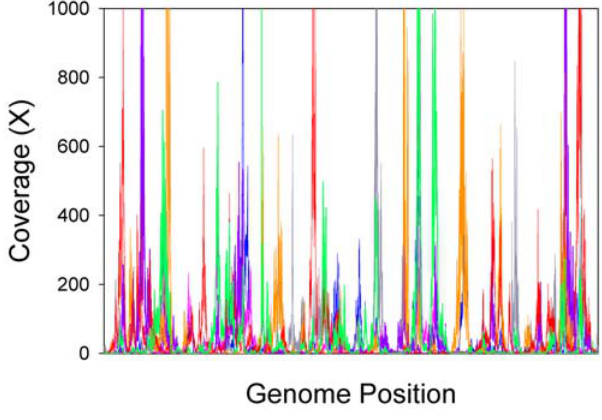
Figure 2. Variation in coverage depth among replicate single- cell WGA libraries. Coverage maps generated from Illumina sequencing data (35 nucleotides read lengths) for seven replicate Prochlorococcus single-cell amplified genomes (SAGs) are overlayed. SAG A (pink), SAG B (blue), SAG C (grey), SAG D (red), SAG E (green), SAG F (orange), and SAG G